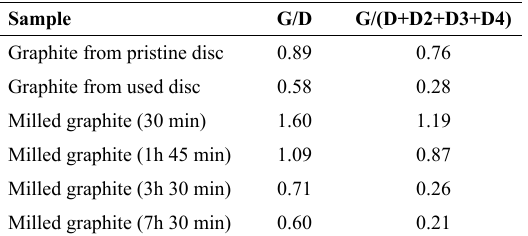
Table 1. Raman band area ratios: G/D and G/(D+D2+D3+D4)